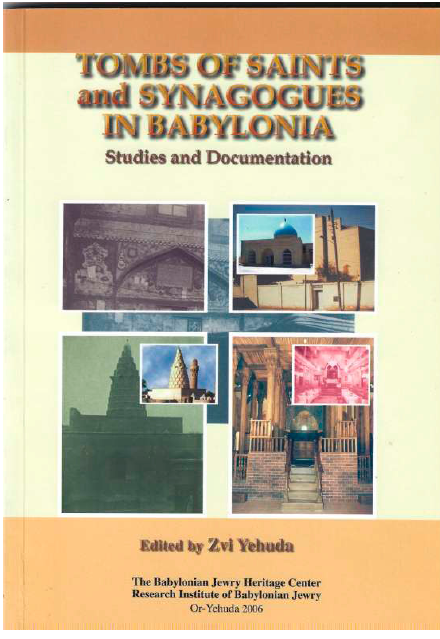
Figure 12. Cover, Zvi Yehuda (ed.). Tombs of Saints and Synagogues in Babylonia (Or-Yehuda,